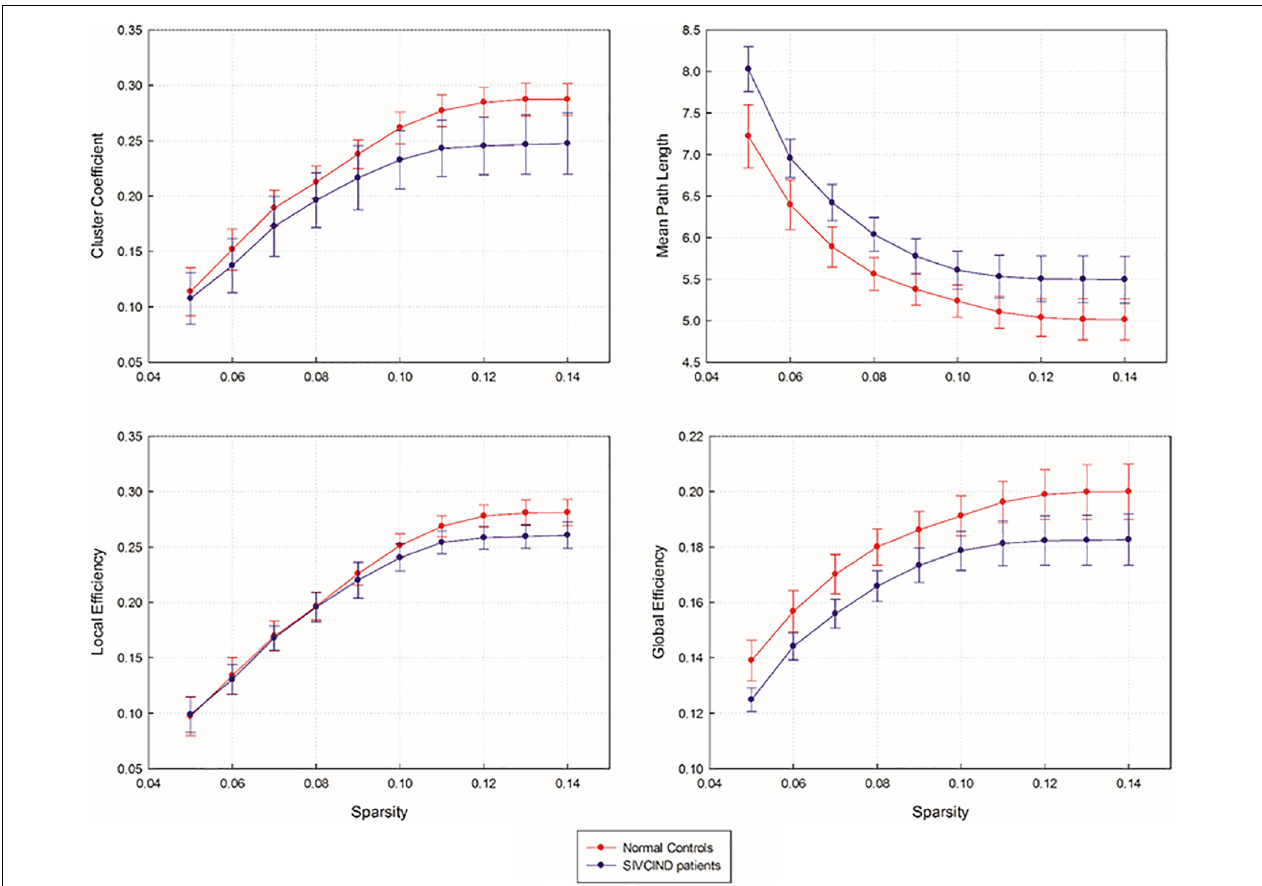
FIGURE 2 | Network topological parameters of structural brain network as a function of sparsity ranging from 5 to 14%. Error bars denote standard deviations.